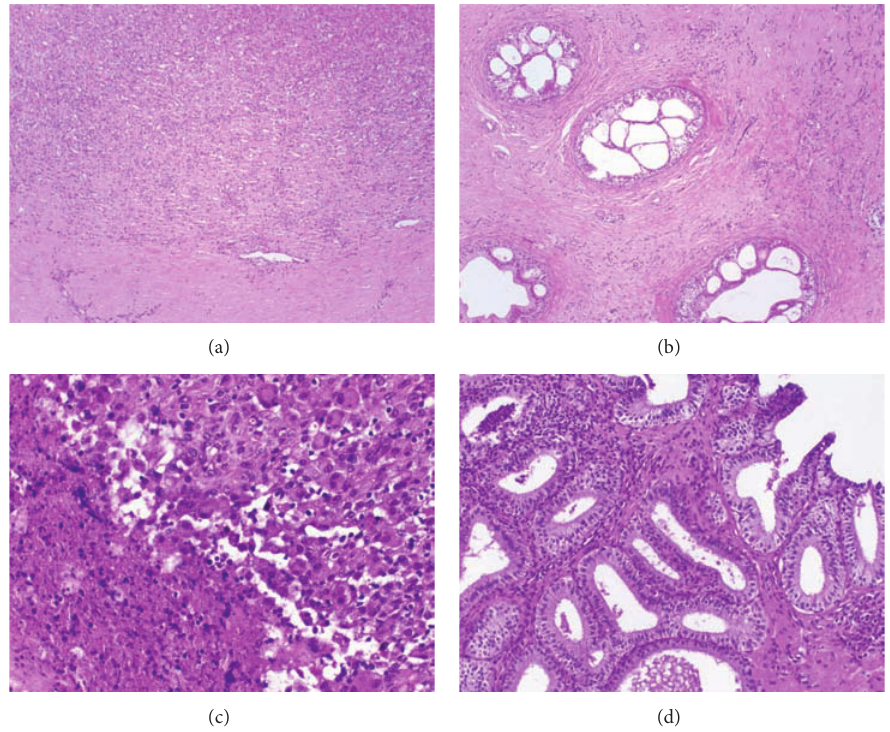
Figure8:Microscopicfindingsinramsexperimentallyinfectedby Histophilussomni .(a)Tailoftheepididymis,diffusemononuclearinfiltrate, HE 100x. (b) Tail of the epididymis, multiple cysts in the ductal epithelium and chronic mononuclear infiltrate, HE 100x. (c) Body of epididymis, sperm granuloma, HE 400x. (d) Ampullae of the vas deferens, diffuse interstitial and intraluminal inflammatory infiltrate, HE